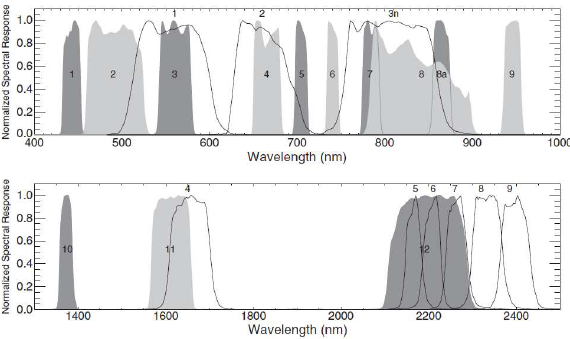
Figure 1. Spectral response functions of the Sentinel-2 (shaded) and ASTER (line) sensors, in the VNIR (top) and SWIR (bottom) wavelength range (Van der Meer et al. 2014).